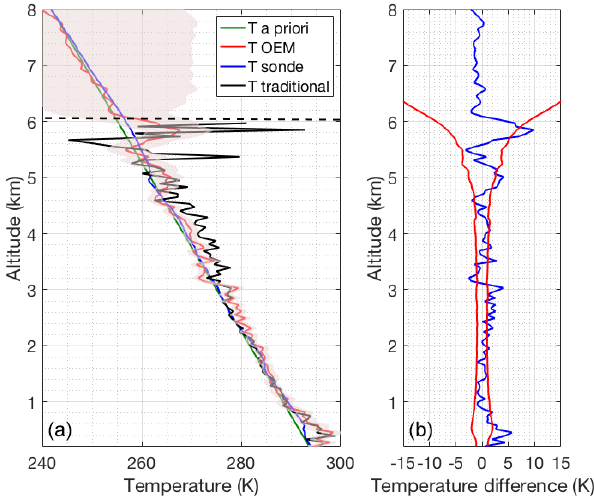
Figure 20. Same as Fig. 3 but for 21 June 2011 with the presence of a lower level cloud, using the OEM.